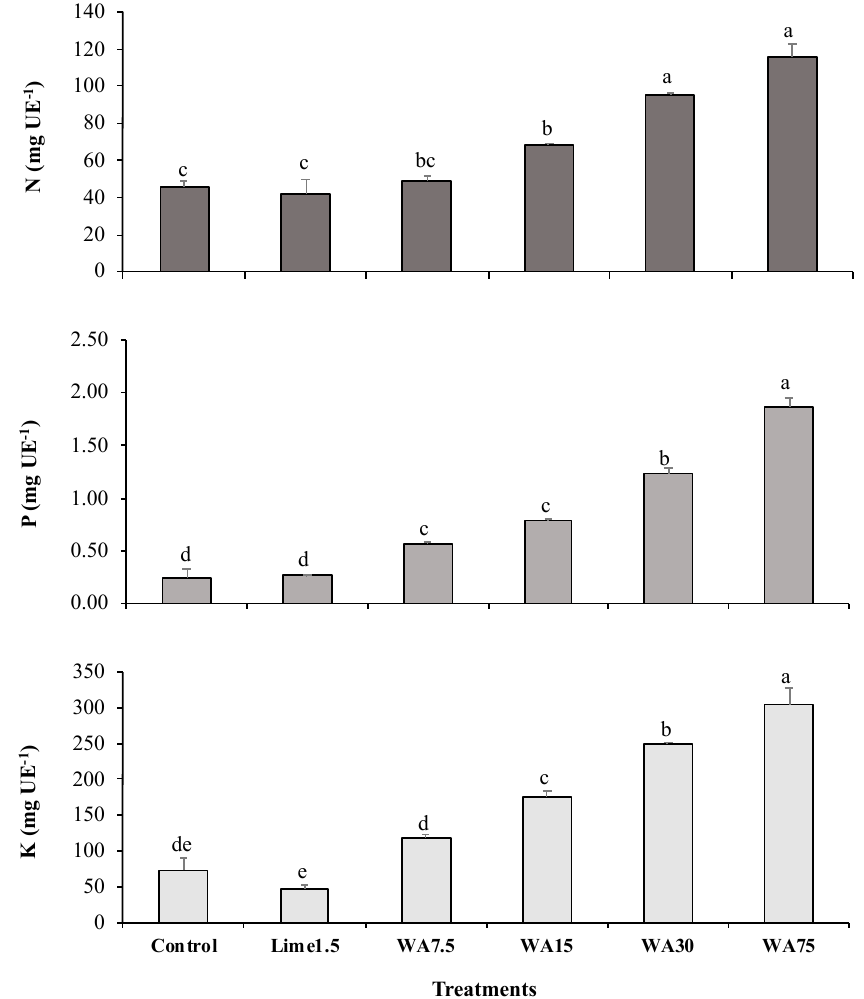
Figure 3. Contents of N, P, and K in ryegrass ( Lolium perenne L.) following treatment with commercial lime and wood ash in Ultisol. Lime1.5, commercial lime at 1.5 g kg − 1 ; WA7.5, WA15, WA30, and WA75: wood ash at 7.5, 15, 30, and 75 g kg − 1 , respectively. EU, experimental unit. Bars indicate standard error of the mean ( n = 3). Means with different letters (a, b, c, d) differ significantly (Tukey’s test, p ≤ 0.05).